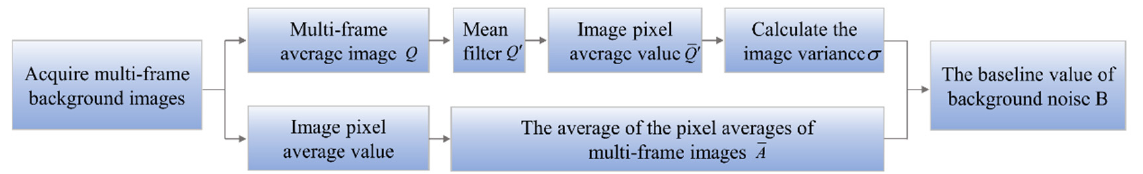
Figure 3. Calculation of the background noise baseline.